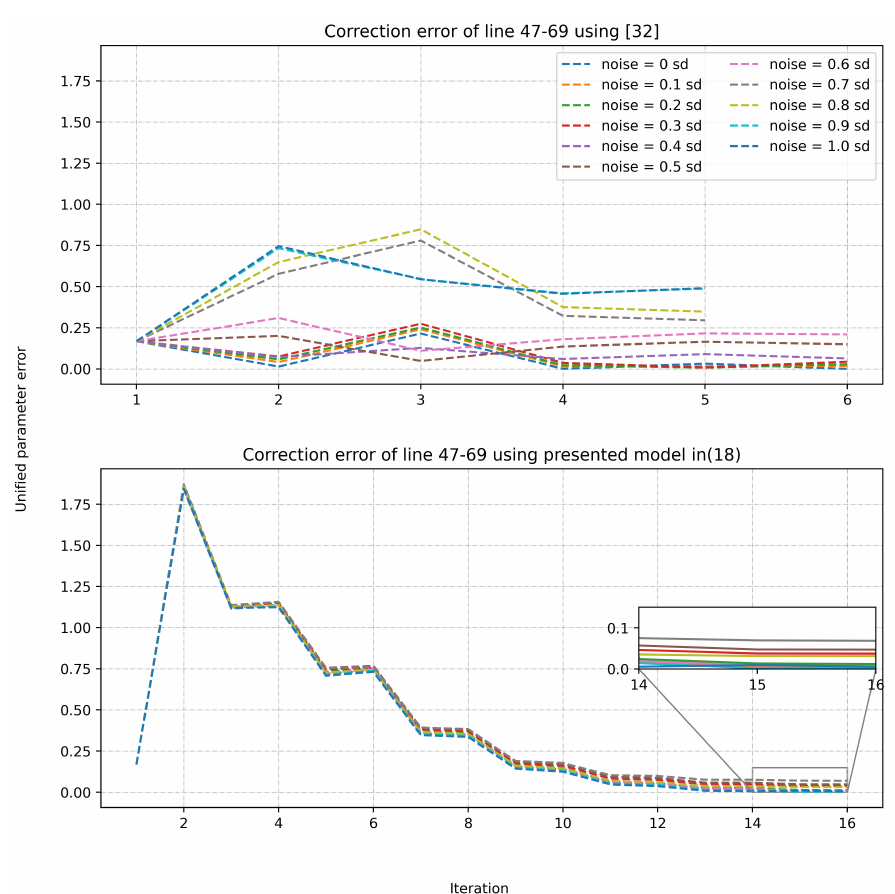
Figure 6. Correction for line